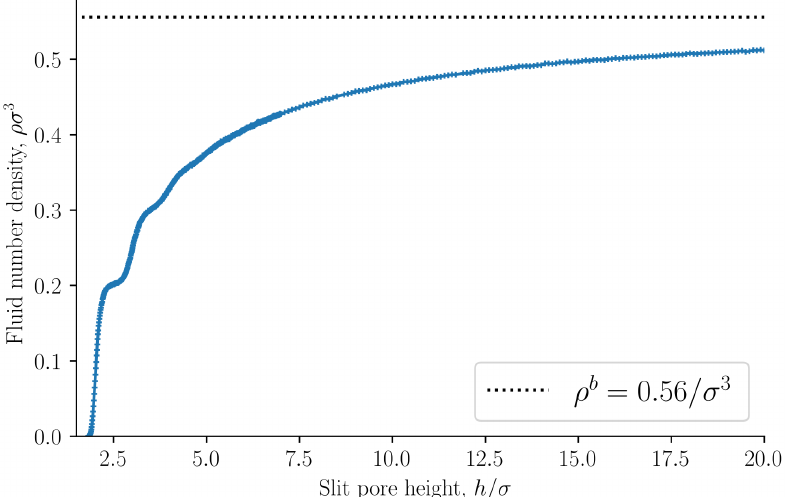
Figure 3. Fluid number density ρ = N / V as a function of slit pore height h . The bulk fluid number density is shown as a dashed